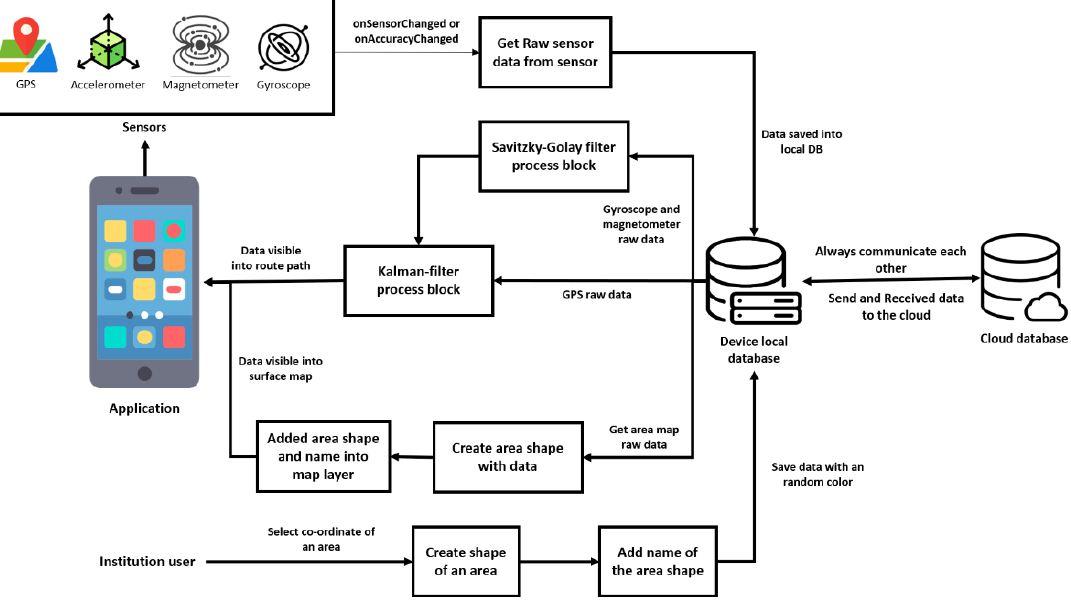
Figure 5. The system architecture of proposed application.